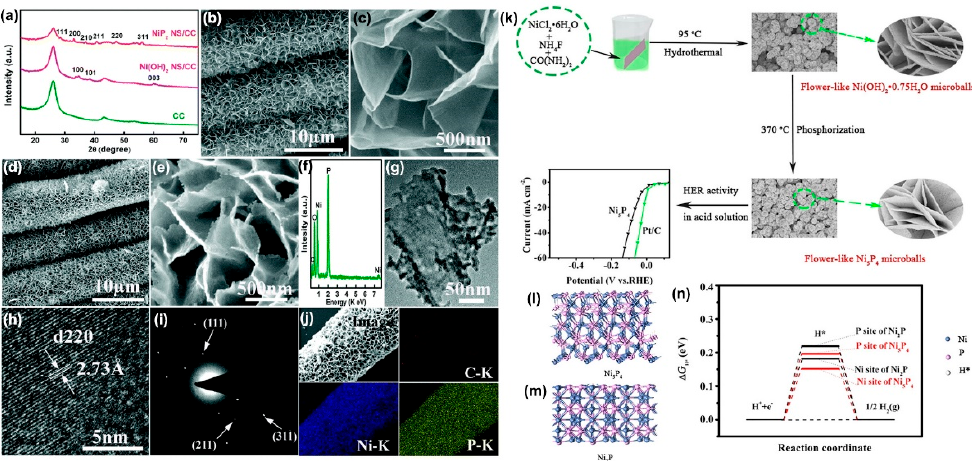
Figure 6. XRD patterns for CC, Ni(OH) 2 NS/CC, and NiP 2 NS/CC ( a ), low ( b ) and high ( c ) magnification SEM images of Ni(OH) 2 NS/CC, low ( d ) and high ( e ) magnification SEM images and the EDX spectrum ( f ) of NiP 2 NS/CC. TEM ( g ) and HRTEM ( h ) images and SAED pattern ( i ) of NiP 2 NS. STEM image and corresponding EDX elemental mapping images of C, Ni, and P for NiP 2 NS/CC ( j ). Reproduced with permission from Reference [75], Copyright the Royal Society of Chemistry, 2014. Schematic diagram of the growth of Ni 5 P 4 and Ni 2 P on Ti foil with di ff erent morphologies ( k ), DFT-calculated HER activities, top view of the theoretical model of an H atom adsorbed on the Ni sites of a Ni 5 P 4 and Ni 2 P surface ( l , m ) and Gibbs Free energy diagrams for the HER on Ni and P of Ni 5 P 4 and Ni 2 P, respectively ( n ). Reproduced with permission from Reference [78], Copyright Wiley-VCH, 2018. Table 3. Summary of the nickel phosphide electrocatalysts prepared through thermal phosphidation with hypophosphite for HER in an acidic electrolyte.